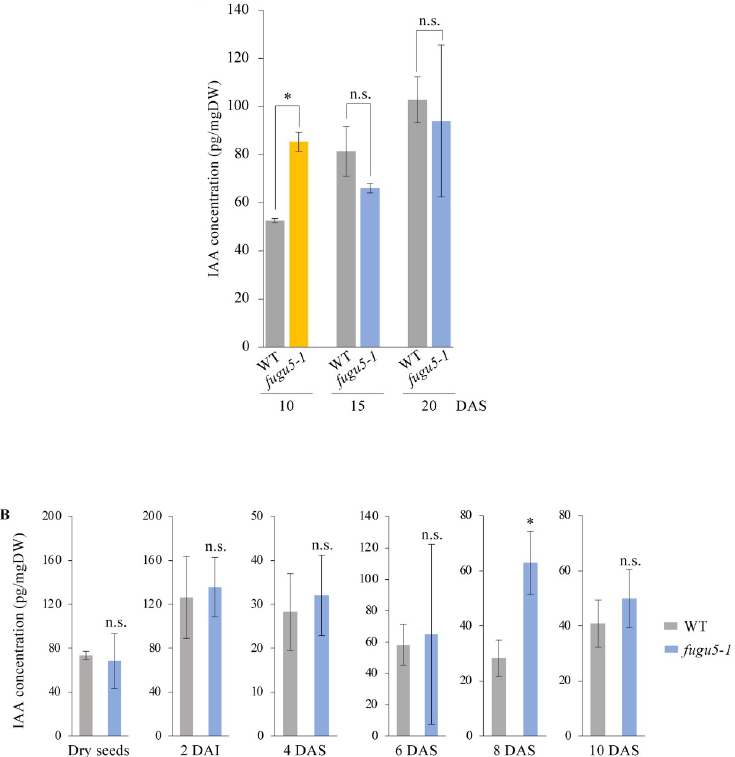
Fig 5. Endogenous Concentration of IAA in fugu5–1 Shoots at Several Developmental Stages. (A) Quantification of endogenous IAA at different developmental stages. Cotyledons of the WT and fugu5–1 were collected at 10, 15, and 20 DAS. Data are means ± SD (n = 3 independent experiments). Single asterisk indicates that fugu5–1 was statistically significantly different compared to the WT (Student’s t-test at P < 0.05). NS, not significant. DAS, days after sowing. (B) Time-course quantification of endogenous IAA in the WT and fugu5–1 . Samples consisted of dry seeds or whole seedling shoots collected at 2 DAI, or 4, 6, 8 and 10 DAS. Data are means ± SD (n � 3 independent experiments). Single asterisk indicates that fugu5–1 was statistically significantly different compared to the WT (Student’s t-test at P < 0.05). DAI, days after induction of seed